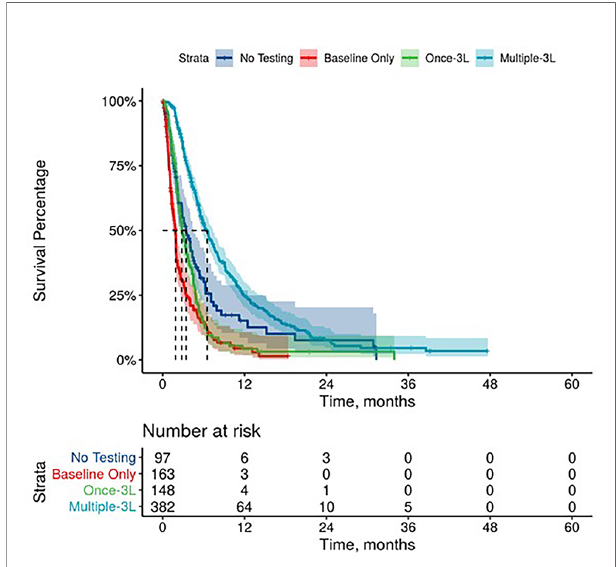
FIGURE 2 | Overall Survival by Carbohydrate Antigen 19-9 Testing Status among patients treated in fi rst line.